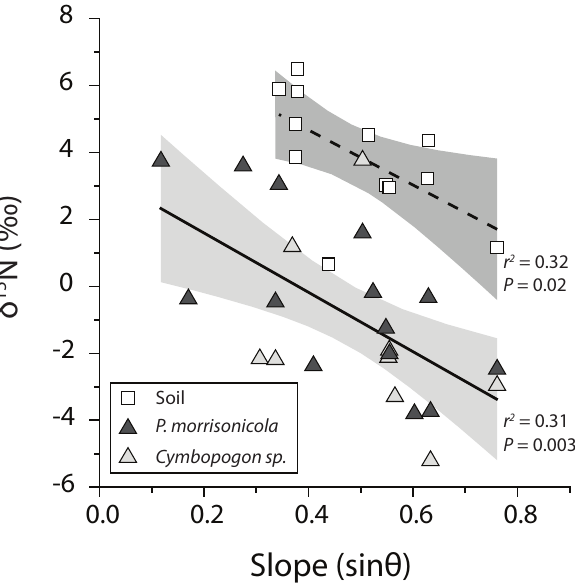
Fig. 3. Relationship between topographic slope (sin θ ) and δ 15 N of soil (squares) and plants (triangles, P. morrisonicola in dark grey and Cymbopogon sp. in light grey) from the Central Range, Tai- wan. Analytical uncertainty is smaller than the point size. The lin- ear fit to the soil (dashed line) and plant (black line) data are shown with 95% confidence bands shaded grey, returning identical gradi- ents, with soil δ 15 N = ( − 8 ± 3) × Slope + (8.0 ± 1.6)‰ and plant δ 15 N = ( − 9 ± 3) × Slope + (3.4 ±